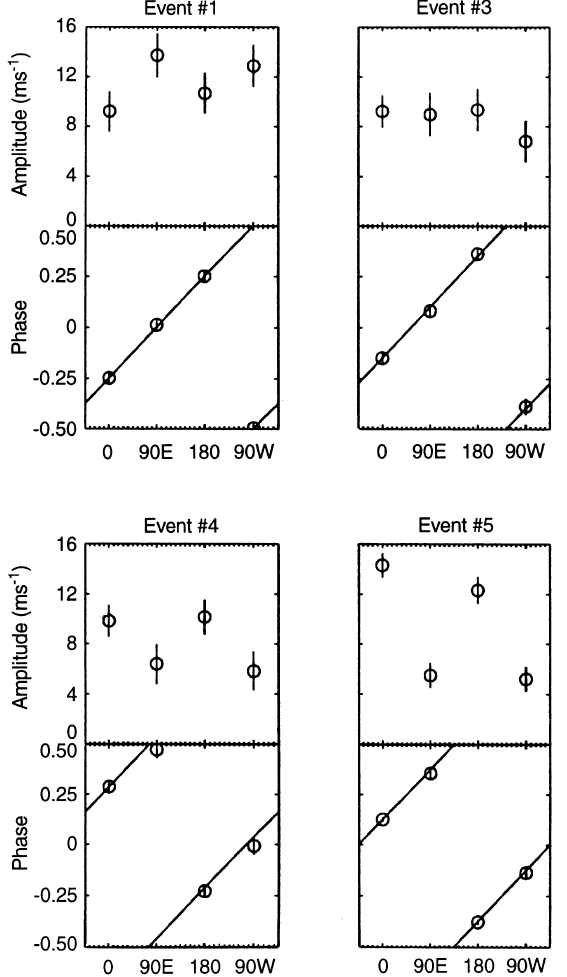
Fig. 11. Results of a linear least squares fit to events 1, 3, 4 and 5. The amplitude ( top panel ) and phases ( bottom panel ) are shown for each of the four viewing directions and each event. The error bar for each of the estimated quantities indicates the 90%